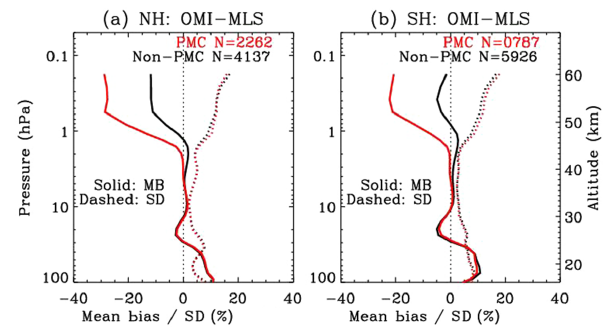
Figure 3. Same as Fig. 2 but for mean biases (solid line) and 1 σ standard deviations (dashed line) of relative differences between OMI and collocated MLS convolved with OMI averaging kernels, (OMI − MLS) / OMI a priori × 100% for PMC (red) and non-PMC (black) pixels. The number of collocations ( N ) is shown in the leg- end.